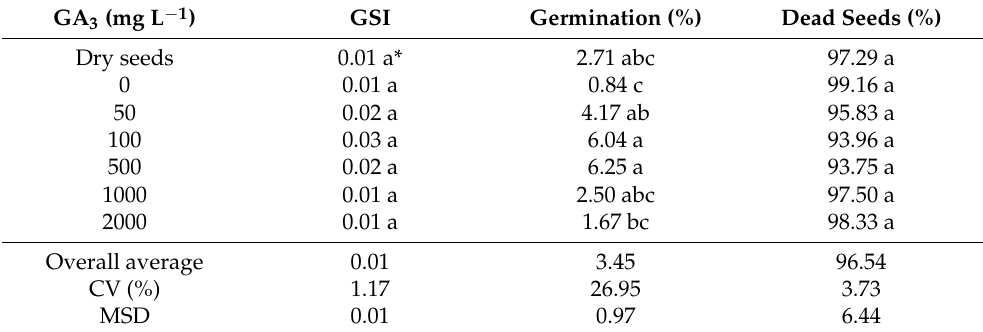
Table 1. Germination speed index (GSI), percentage of germination and dead seeds of C. brasiliense stored for seven months, pre-soaked in concentrations of GA 3 and without pre-soaking (dry seeds) at 60 days after sowing in